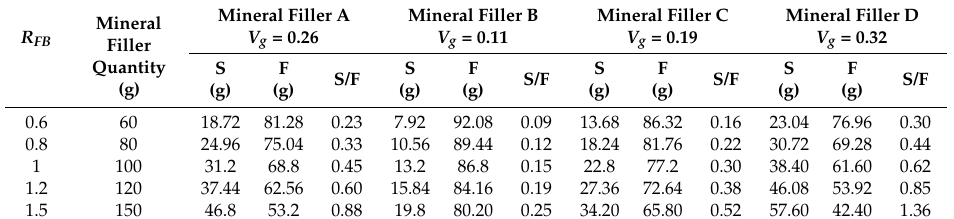
Table 4. Quantity of the Fixed and Free Bitumens Prepared by Combining Bitumen (100 g) and the Four Kinds of Mineral Filler under Five Different Filler–Bitumen Ratios ( R FB s ).